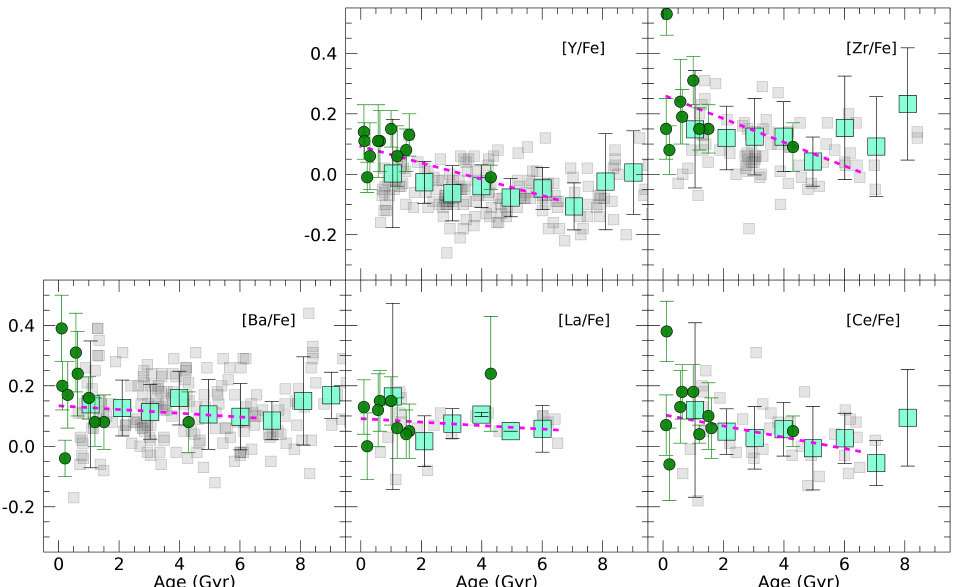
Figure 1. Abundance ratios [El/Fe] vs. age for the thin-disc stars (binned results, bin 0.1 dex wide–cyan squares, and individual stars–grey squares) and the open clusters located in the solar neighbourhood (green circles). The magenta dashed lines are the weighted linear fits to the cumulative sample of solar neighbourhood clusters and thin-disc field stars for stellar ages < 8 Gyr (figure adapted from